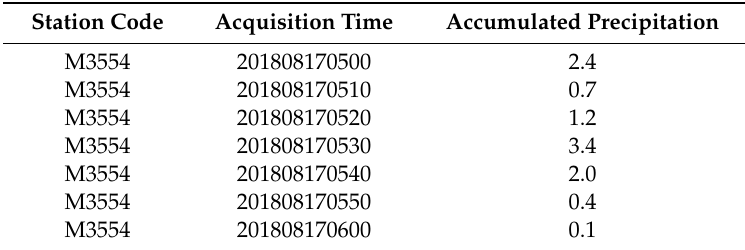
Table 4. Rainfall data format description and